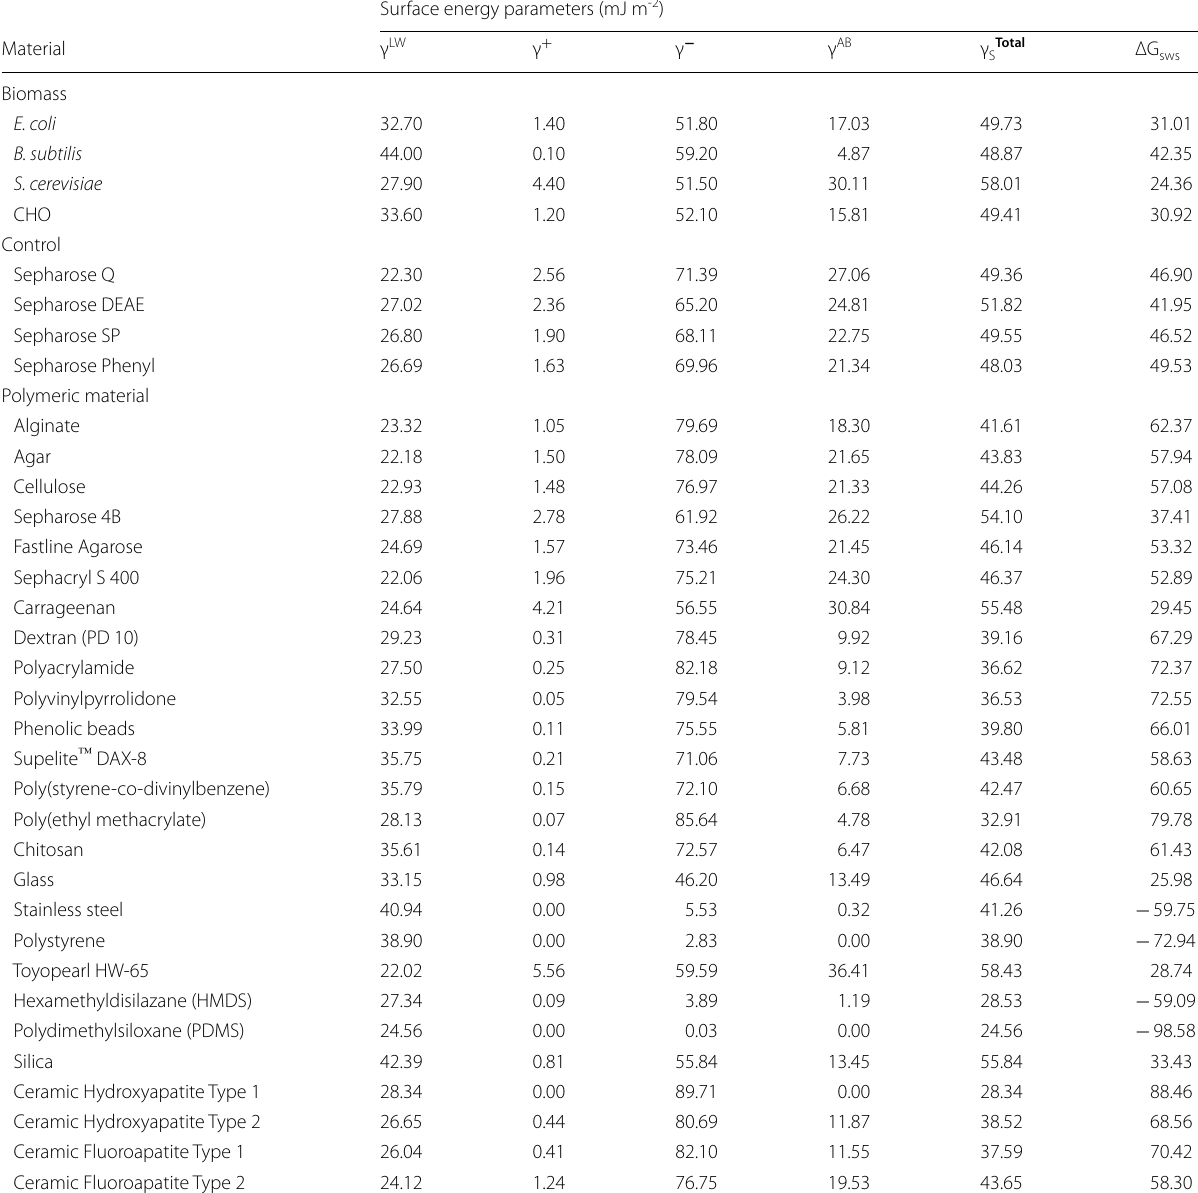
Table 3 Surface energy parameters for biomass, control adsorbents and polymeric